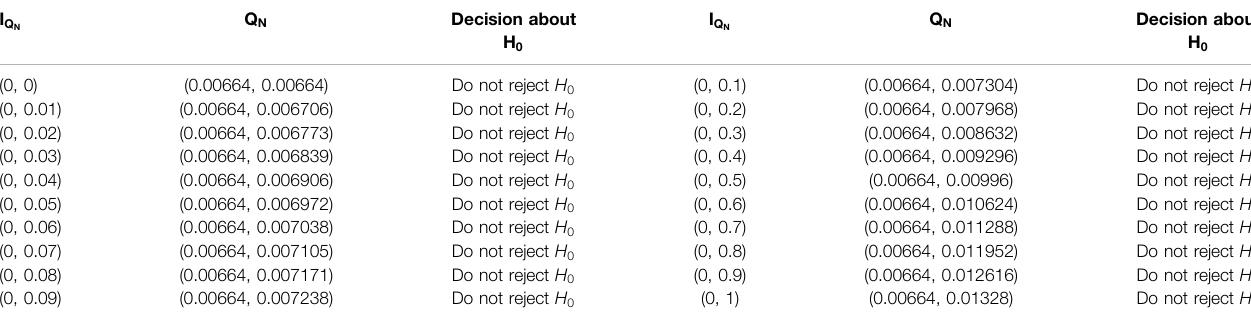
TABLE 2 | The effect of Indeterminacy on Q N